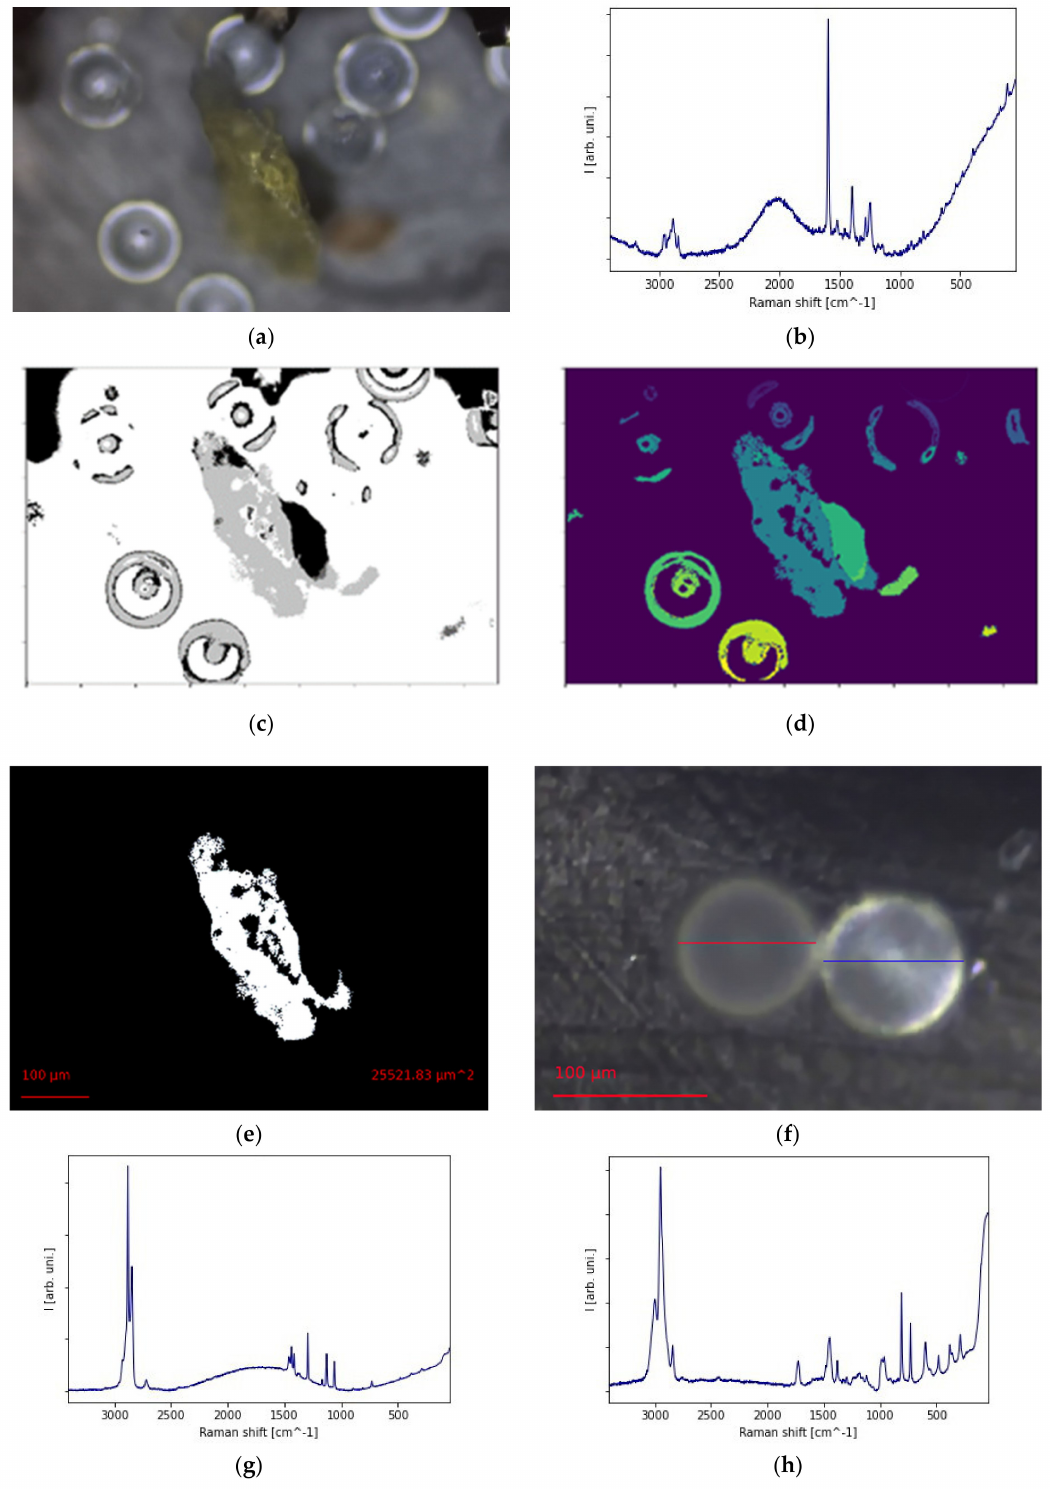
Figure 2. Different debris from a freshwater system mapped on the GFF filter: ( a ) polypropylene (PP) with ( b ) its Raman spectrum and ( c – e ) the steps towards object detection and its calculated surface, ( f ) two similar spheres, but identified by Raman spectroscopy as ( g ) polyethylene (PE) and ( h ) poly(methyl methacrylate)